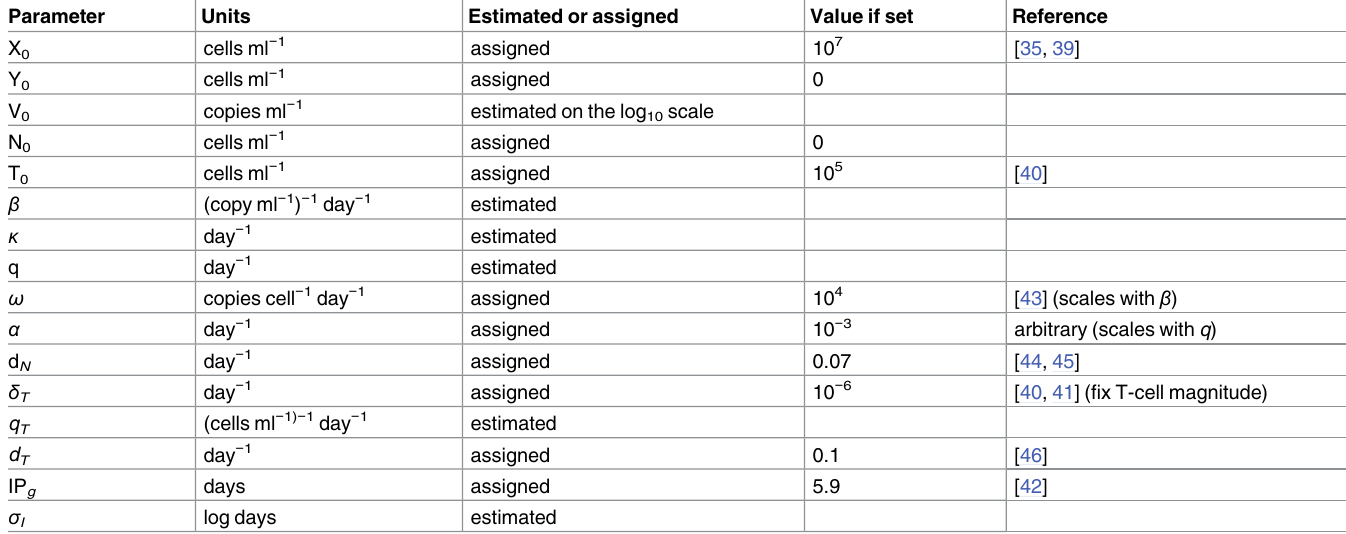
Table 1. Initial conditions and model